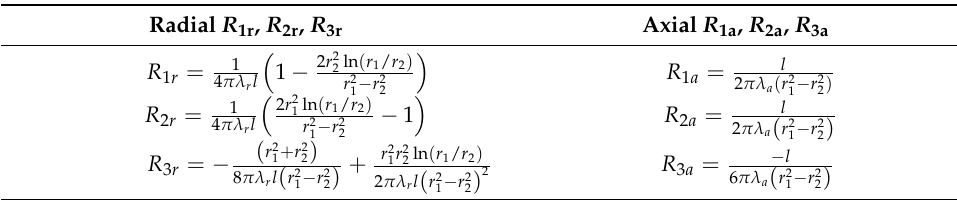
Table 1. Thermal resistance definition of “H” type [15–19].